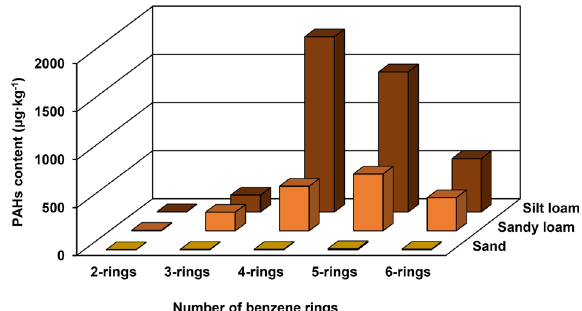
Figure 3. PAHs content (μg/kg) in soil depending on the benzene rings, was generated using Statistica 13 software.